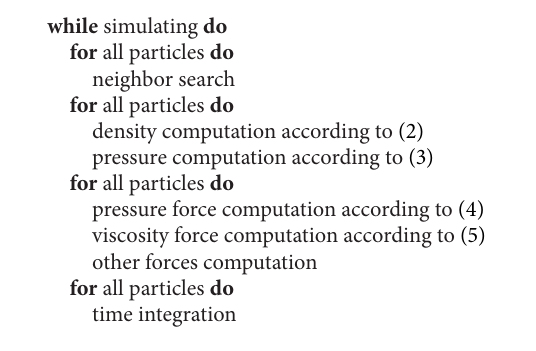
Algorithm 1: Standard SPH/WCSPH